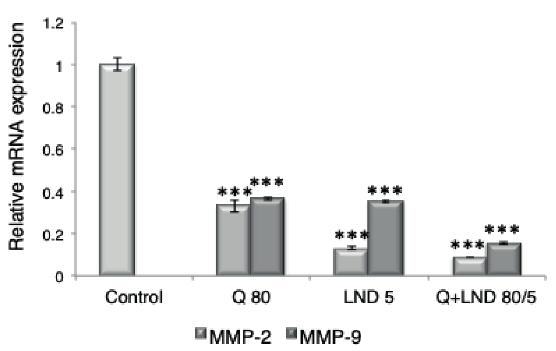
Figure 5. Q+LND combination increased total caspase levels of MCF-7 cells signifi cantly. The cells were treated with 80 μM of quercetin, 5 μM of LND and 80/5 μM of Q+LND combination for 24 hr and total caspase levels were detected with multicaspase assay kit. Values are mean±SD of three samples of medium from wells containing MCF-7 cells. The differences are *, ** and *** from control: p < 0.05, p<0.01 and p < 0.0001, respectively.